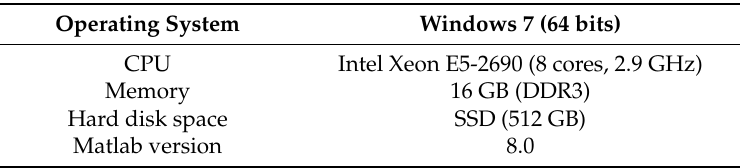
Table 1. Configuration of the workstation.